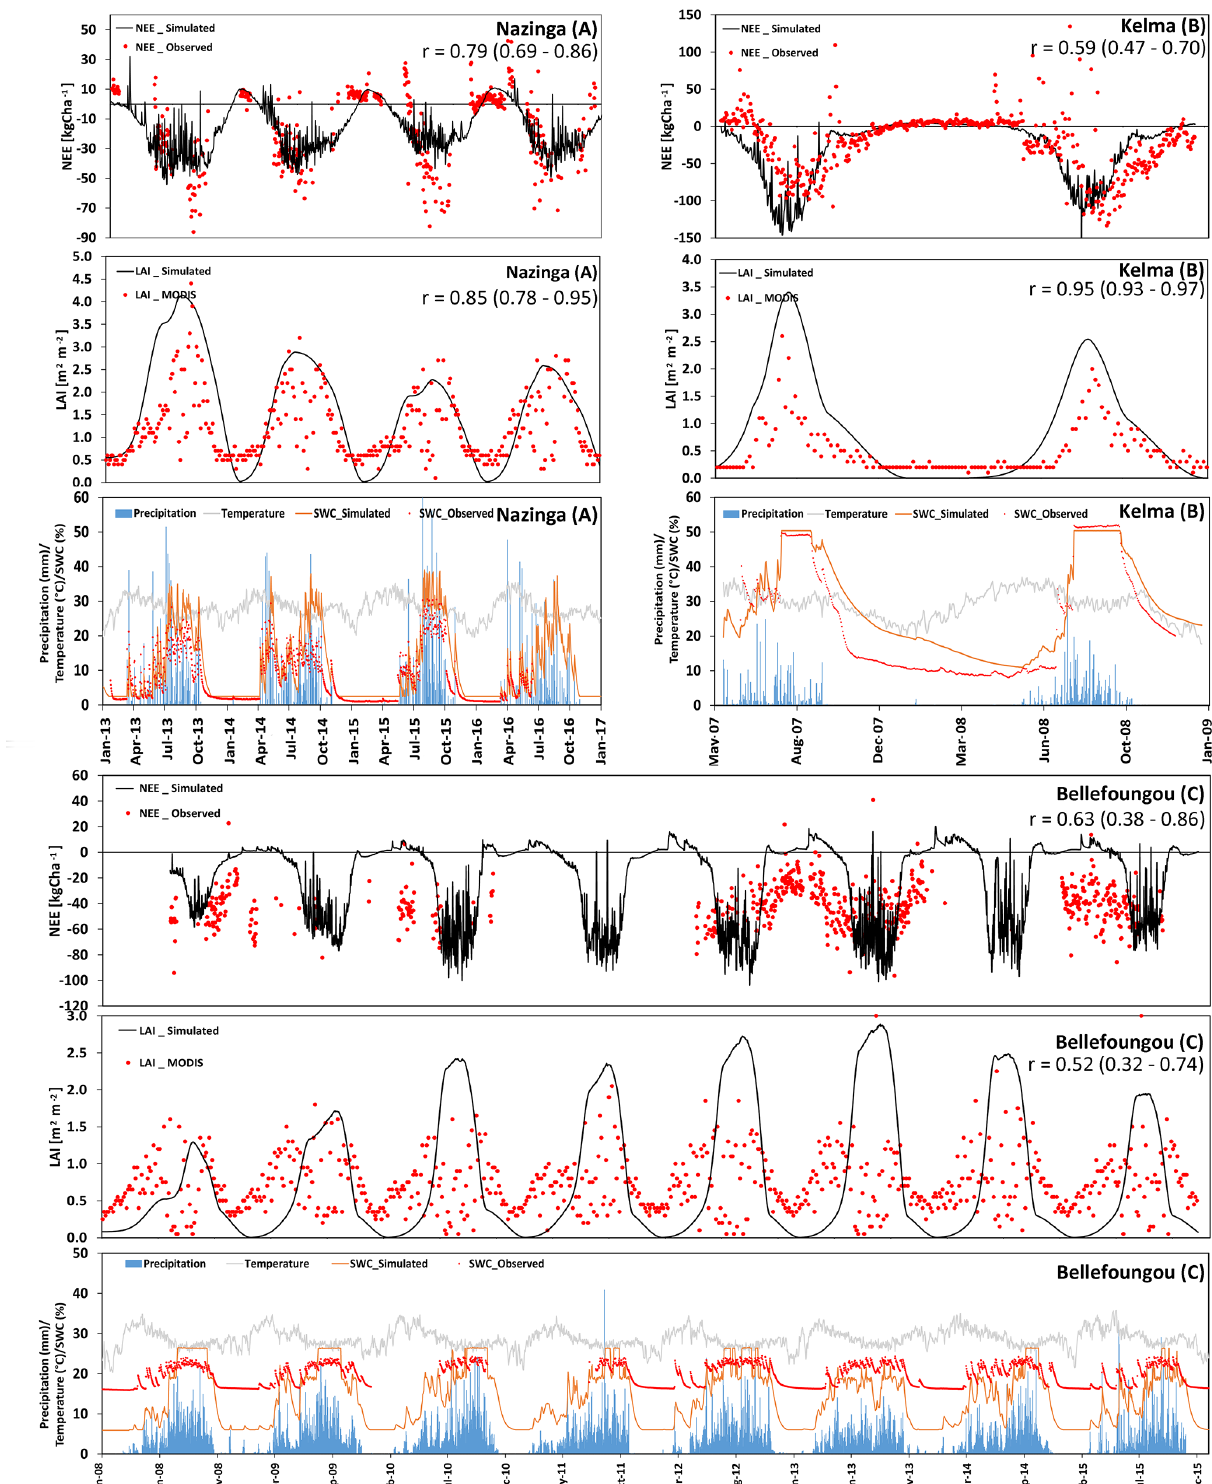
Figure 7. (a–c) Time series of the observed and modeled NEE (kgha − 1 ; negative values represent a flux to the biosphere, and positive values represent a flux to atmosphere), LAI (m 2 m − 2 ), and soil-water content (at 10cm depth). In addition, precipitation and temperature at different tree-dominated grassland/woodland sites in the Sahelian (Kelma) and Sudanian (Nazinga, Bellefoungou) ecological zones are presented.